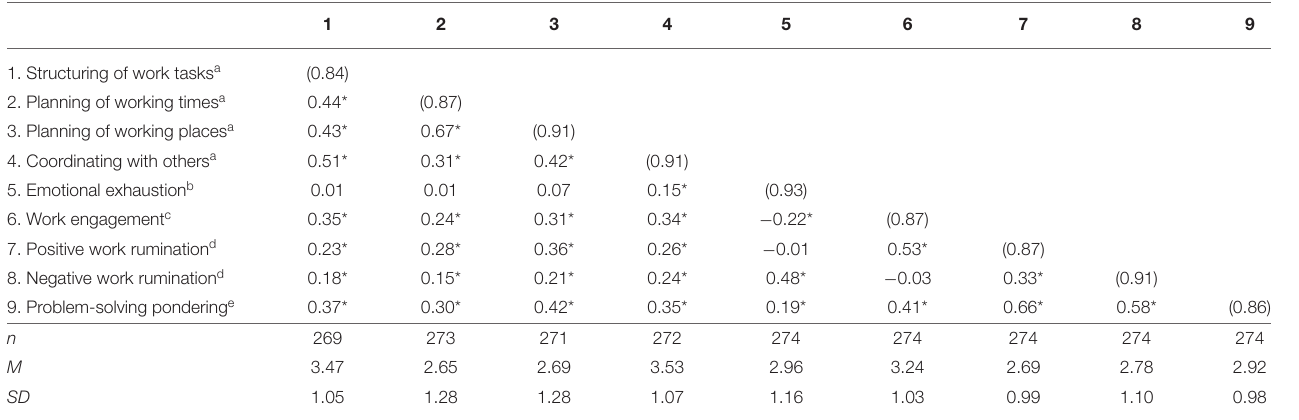
TABLE 5 | Descriptive statistics, Cronbach’s alphas, and correlations for study